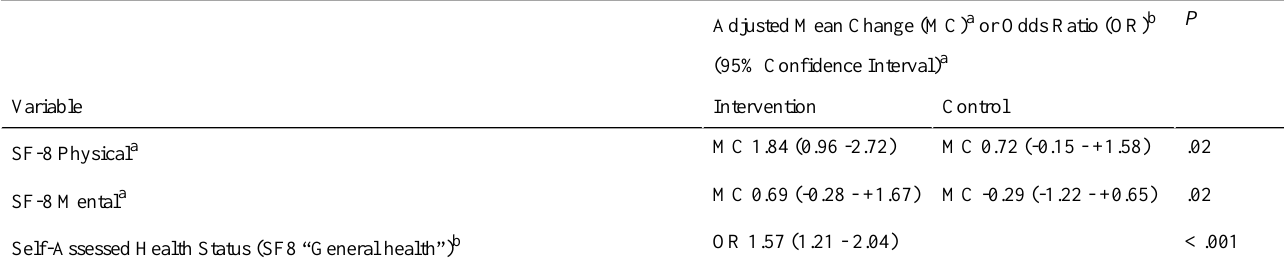
P Adjusted Mean Change (MC) a or Odds Ratio (OR) b